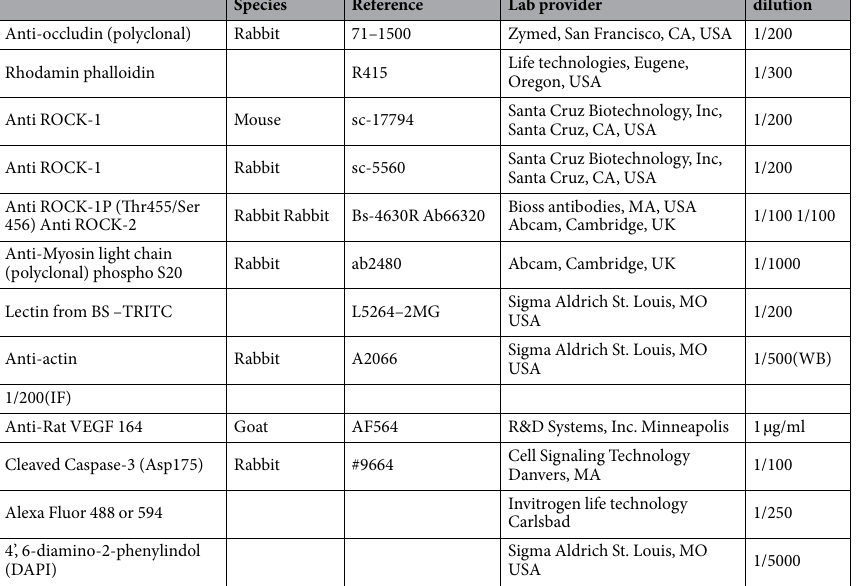
Intravenous injection of FITC-Dextran.